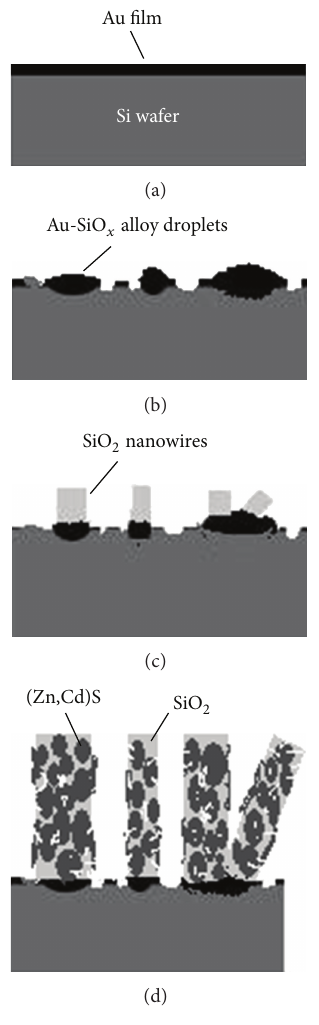
Figure 3: Illustration of the growth mechanism of the as-prepared 1D porous nanostructure: (a) gold film on silicon wafer; (b) Au-SiO alloy droplets; (c) formation of SiO 2 nanowires by reaction between silicon and oxygen in the system; and (d) ZnS and CdS vapor deposited on the surface of the SiO 2 nanowires and crystallized to form (Zn,Cd)S/SiO 2 composite